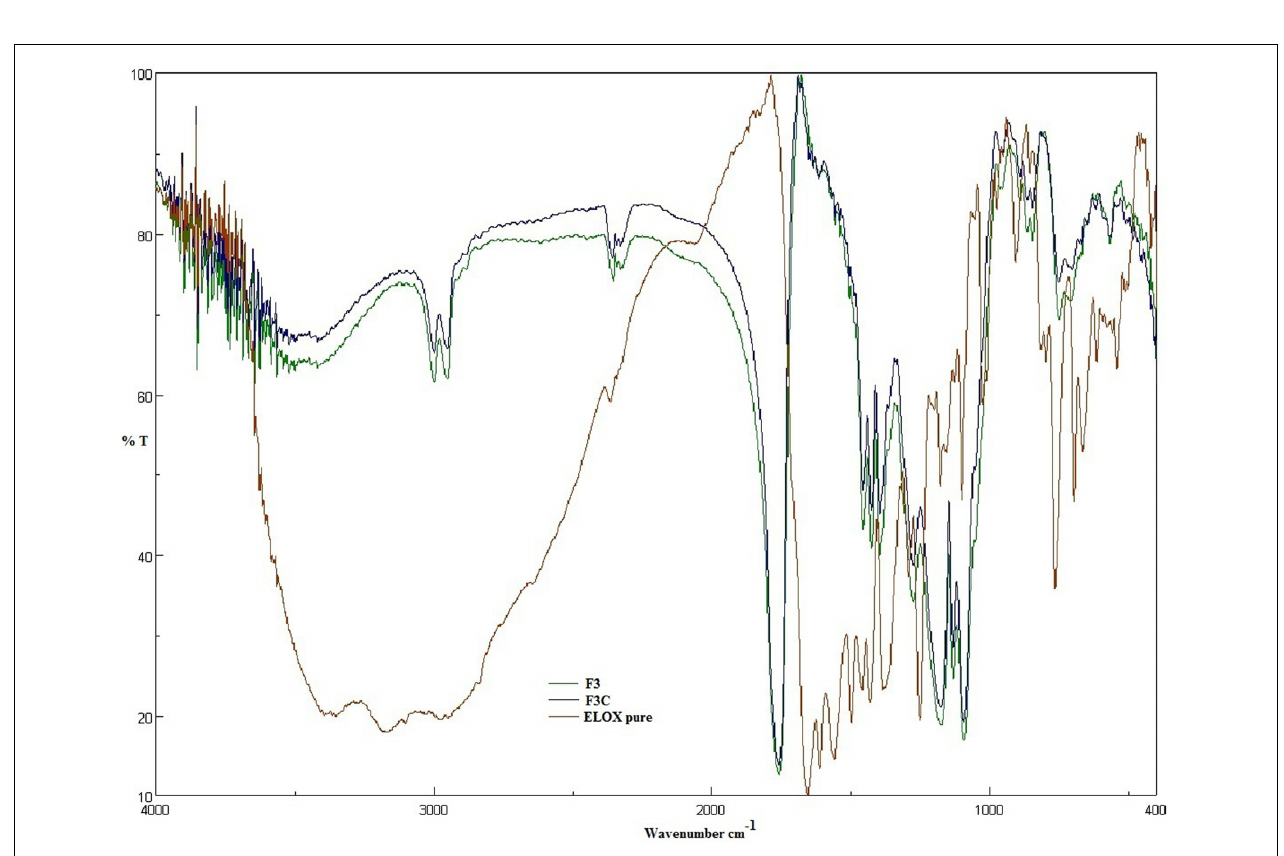
FIGURE 4 | FTIR spectra of Eluxadoline (ELUX), plain and coated PLGA NPs.